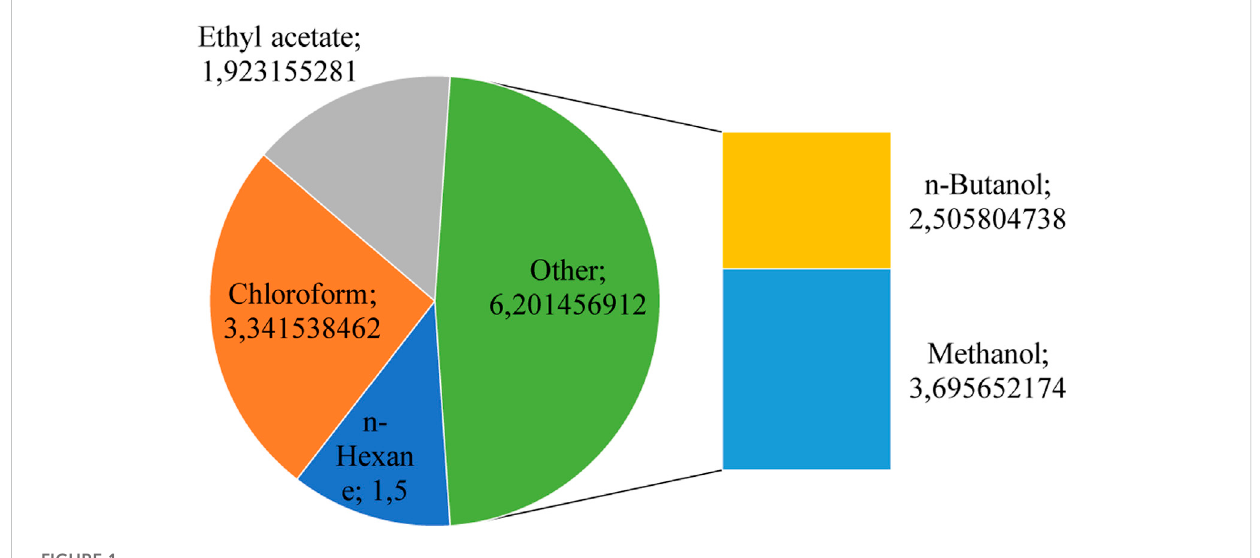
FIGURE 1 Percentage yield of Amomum subulatum seeds extracts.